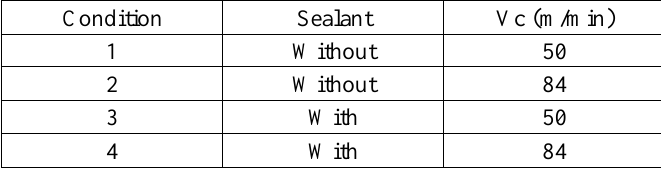
Table 5: Sample machining initial conditions.